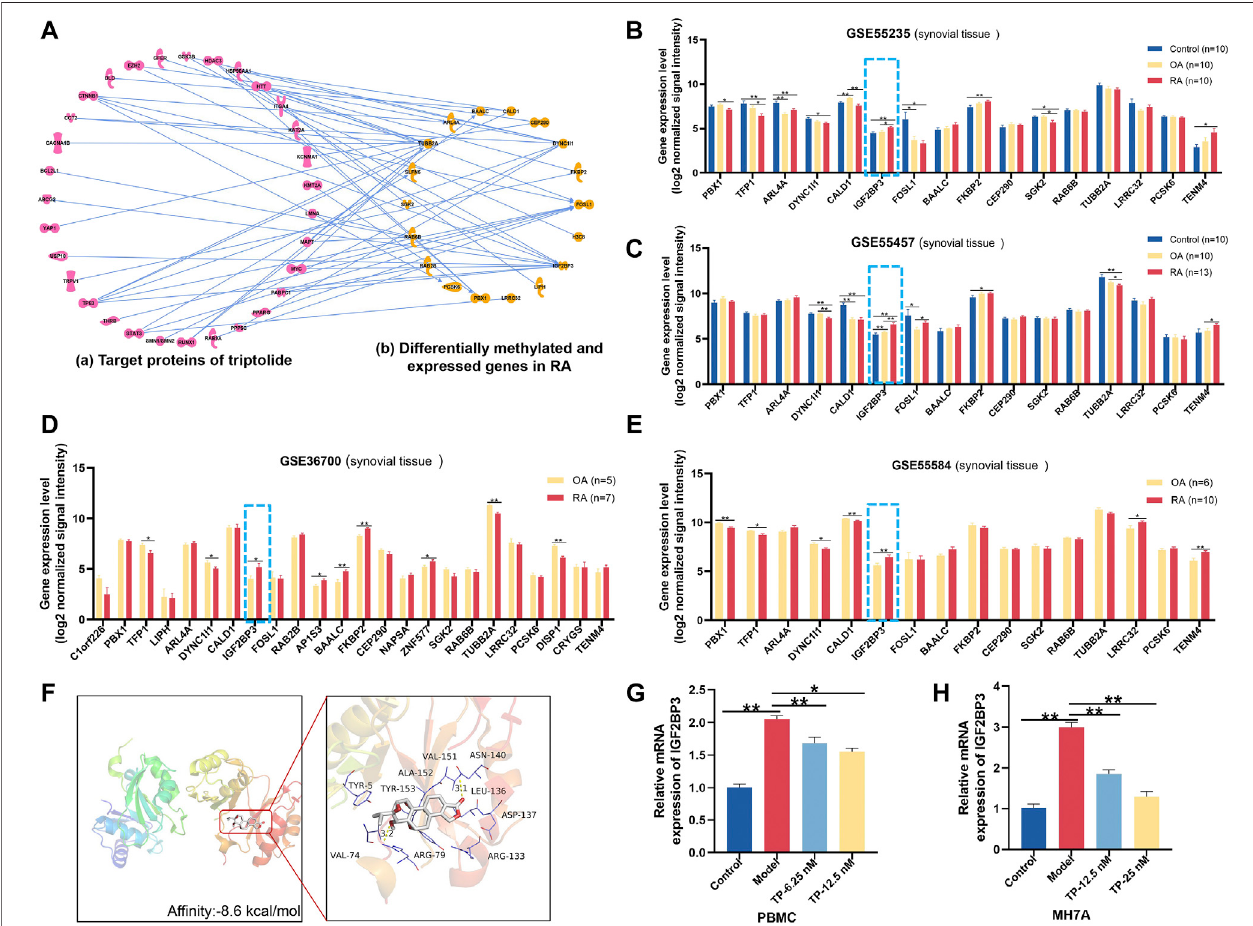
FIGURE 6 | Potential target analysis of TP. (A) Network analysis between genes with great variation in both the m 6 A modi fi cation and mRNA levels and target proteinsofTP. (B – E) GeneexpressionofIGF2BP3insynovialtissuesamplesofGEOdatasets. (F) MoleculardockingofIGF2BP3andTP.Inthepictureontheright,thick sticksrepresenttheTPmolecule,andthinlinesrepresentresiduesintheproteinbindingsite. (G,H) mRNAexpressionofIGF2BP3inPBMCsandMH7A.* p < 0.05 , ** p < 0.01 . TP, triptolide; IGF2BP3, insulin-like growth factor 2 mRNA-binding protein 3; GEO, Gene Expression Omnibus; and PBMCs, peripheral blood mononuclear